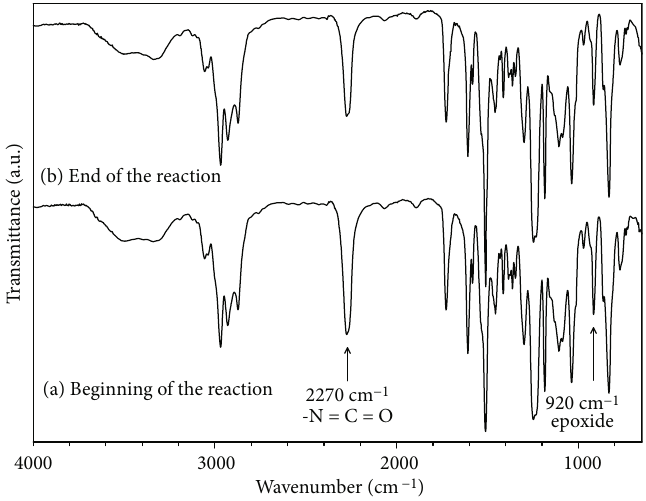
Figure 3: FTIR analysis of PU-EP IPNs before and after grafting